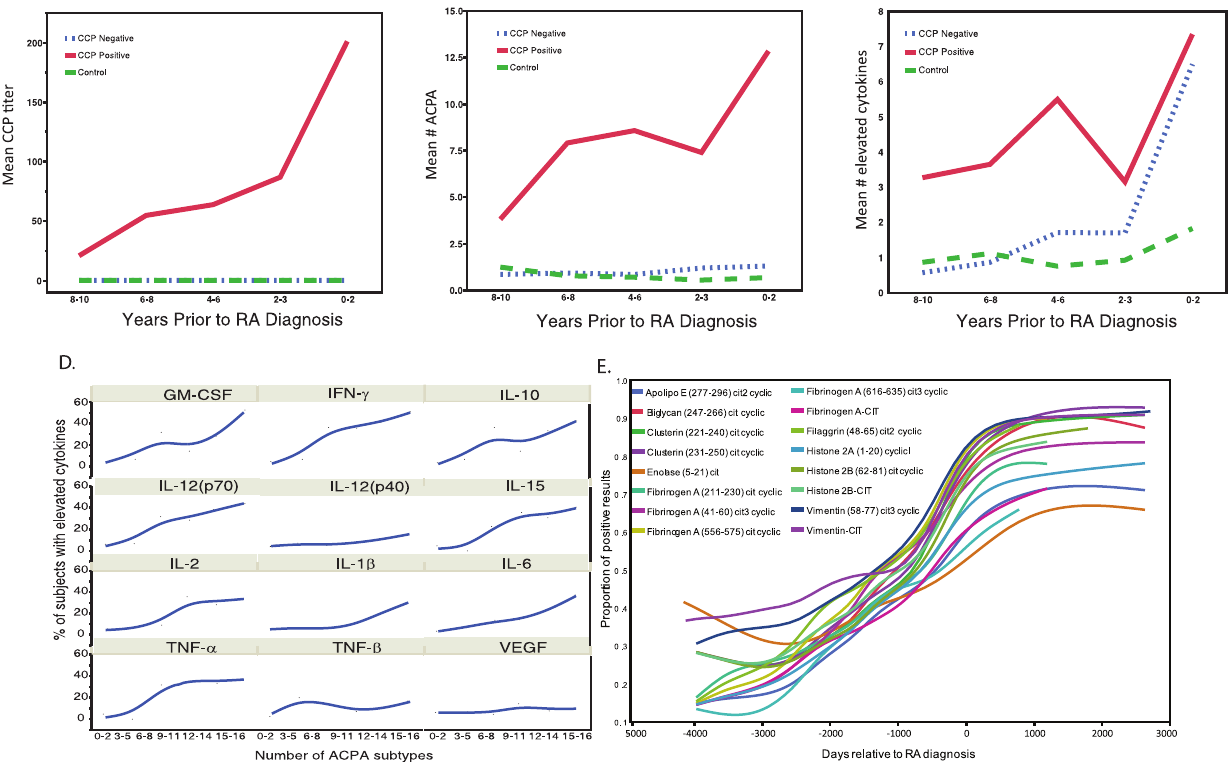
Figure 1. The number of elevated autoantibodies and cytokines increase as individuals in the preclinical period approach the clinical diagnosis of RA. A–C, Mean titers of CCP2 (A), mean total number of ACPAs (B), and mean total number of cytokines (C) were evaluated at each time preclinical timepoint demonstrating a parallel rise in number of ACPA epitopes with rise in anti-CCP2 titer. D, The percent of subjects with elevated levels of each cytokine was evaluated in relation to number of ACPA subtypes present (representative examples of 48 measured cytokines) E, The proportion of subjects positive for each ACPA subtype was evaluated over the preclinical period. The X axis represents days relative to the diagnosis of RA. The Y axis represents the proportion of pre-clinical RA patients with positive value for each marker relative to total number of specimens available for analysis at that timepoint. A–E, Anti-CCP2 antibody titers were measured by CCP2 ELISA (A), ACPA subtypes were measured using a custom multiplex autoantigen bead array, serum cytokine concentrations were measured using commercial bead based multiplex cytokine kits.